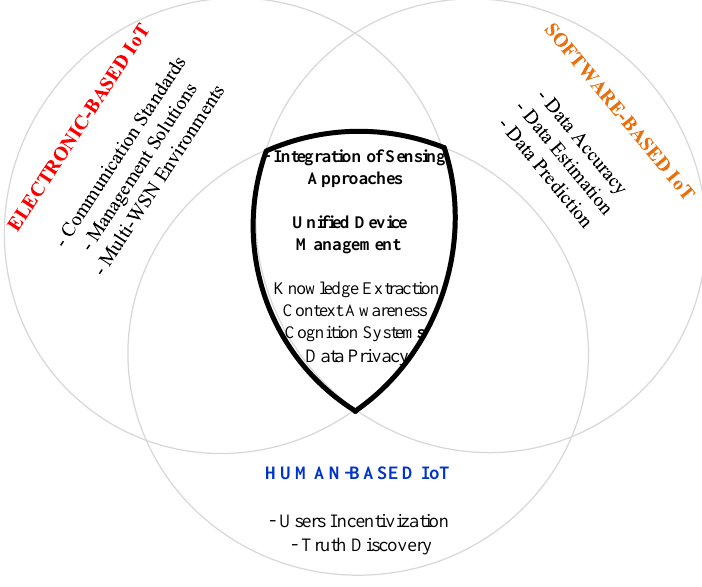
Figure 3. Main open issues per sensing approach.